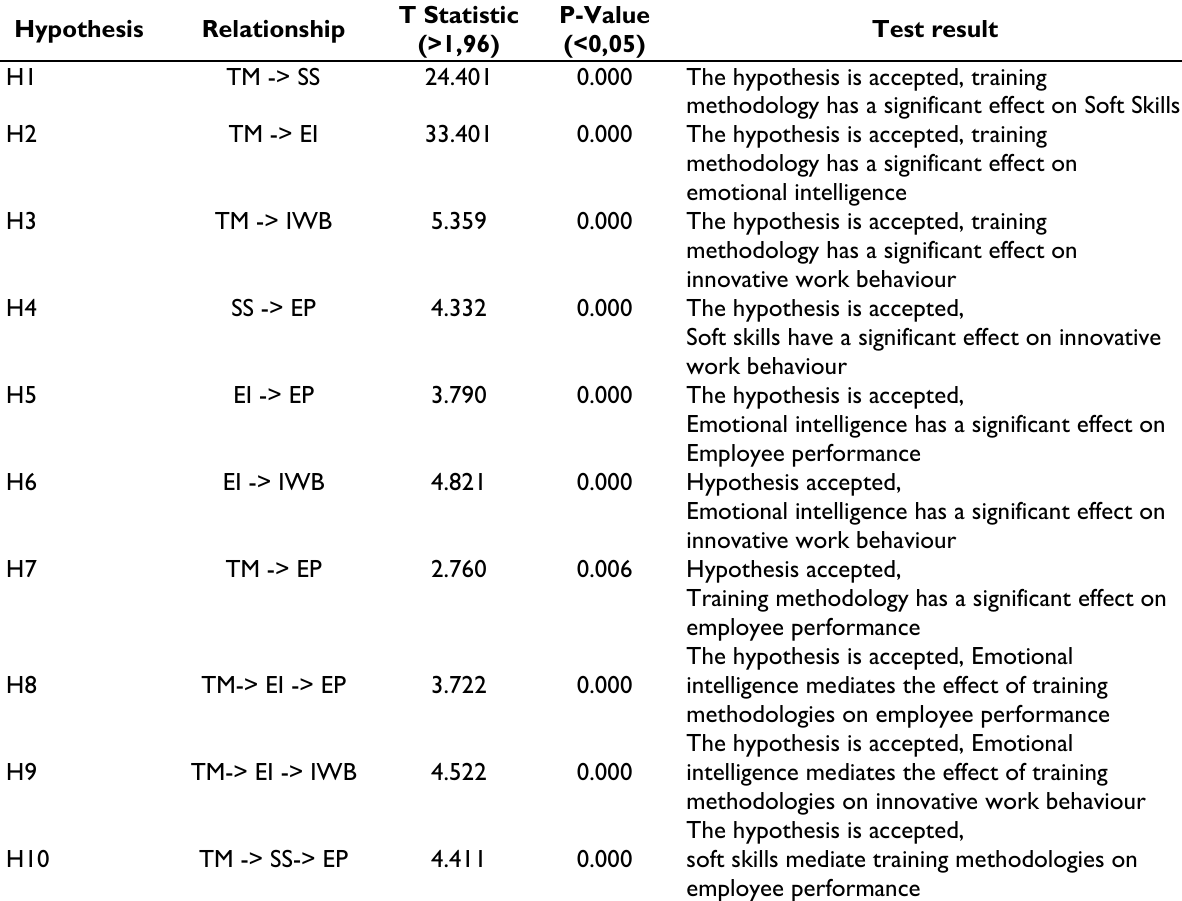
Table 6. Hypothesis Testing